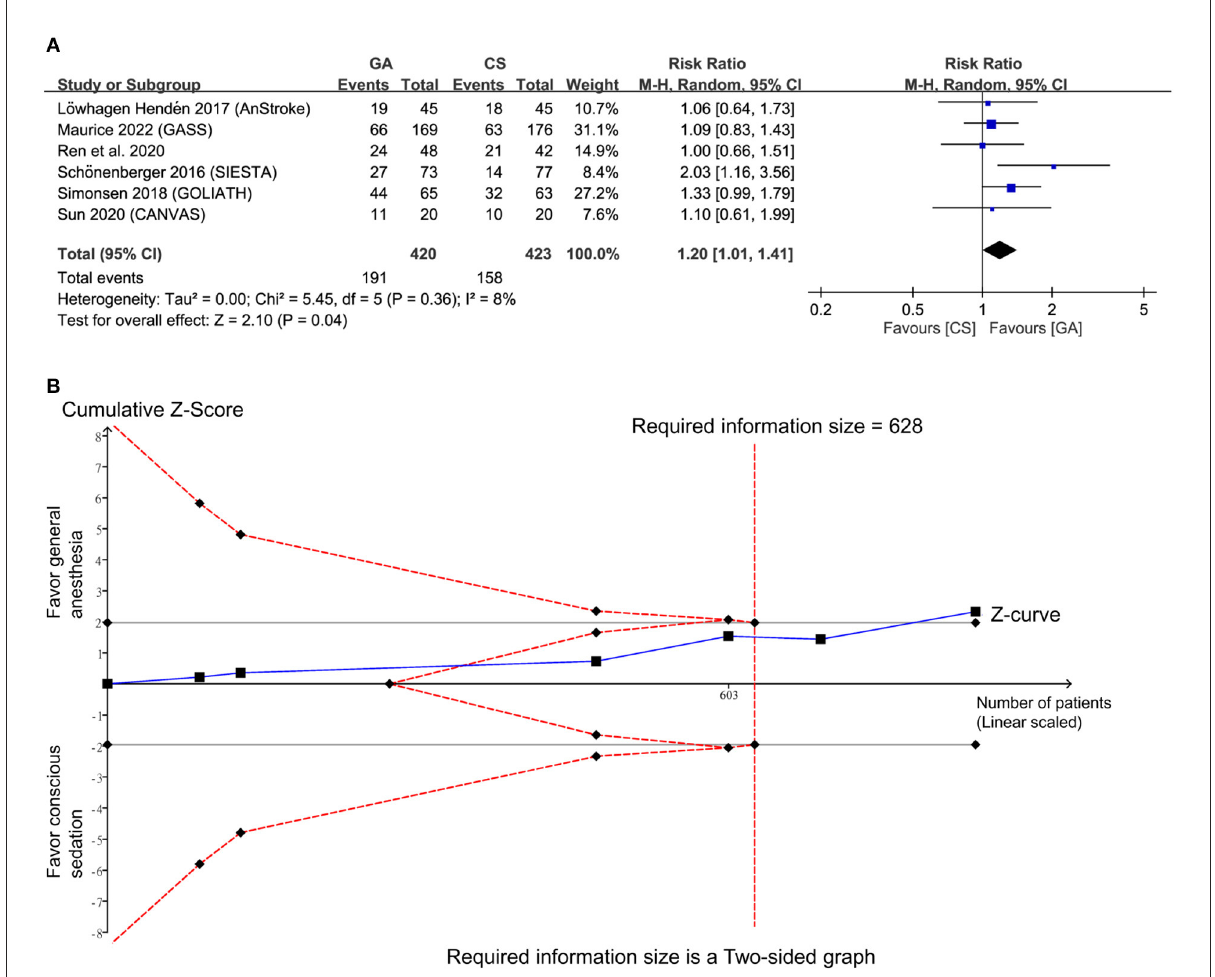
FIGURE3 (A) Forest plot comparing the risk of good functional outcome between general anesthesia (GA) and conscious sedation (CS) groups. M-H, Mantel-Haenszel; CI, confidence interval; (B) Trial sequential analysis of risk of good functional outcome. The risk of type I error was set at 5% with a power of